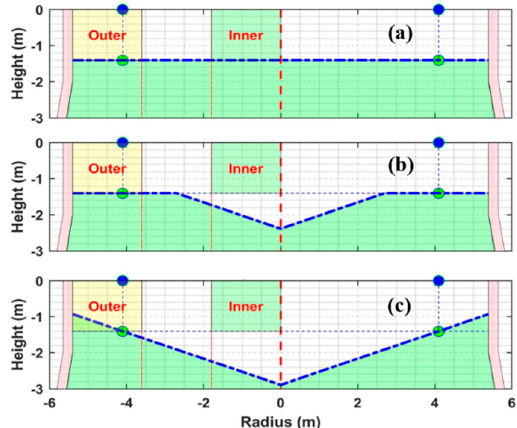
Figure 5. Initial surfaces with three different plateau widths. Green solid circle at the end of the vertical dashed line indicates the charging level, i.e., the level of the burden where charging is triggered.